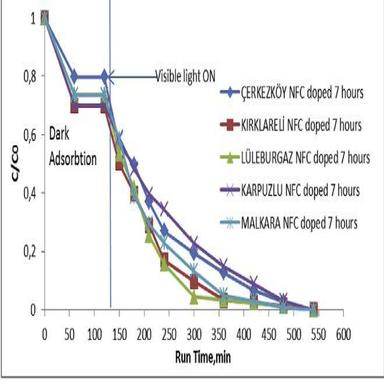
Comparison of UV–Vis spectrophotometer measurement results after NFC-doped TiO2 photocatalytic advanced oxidation processes of all domestic and industrial wastewater treatment plant effluents.